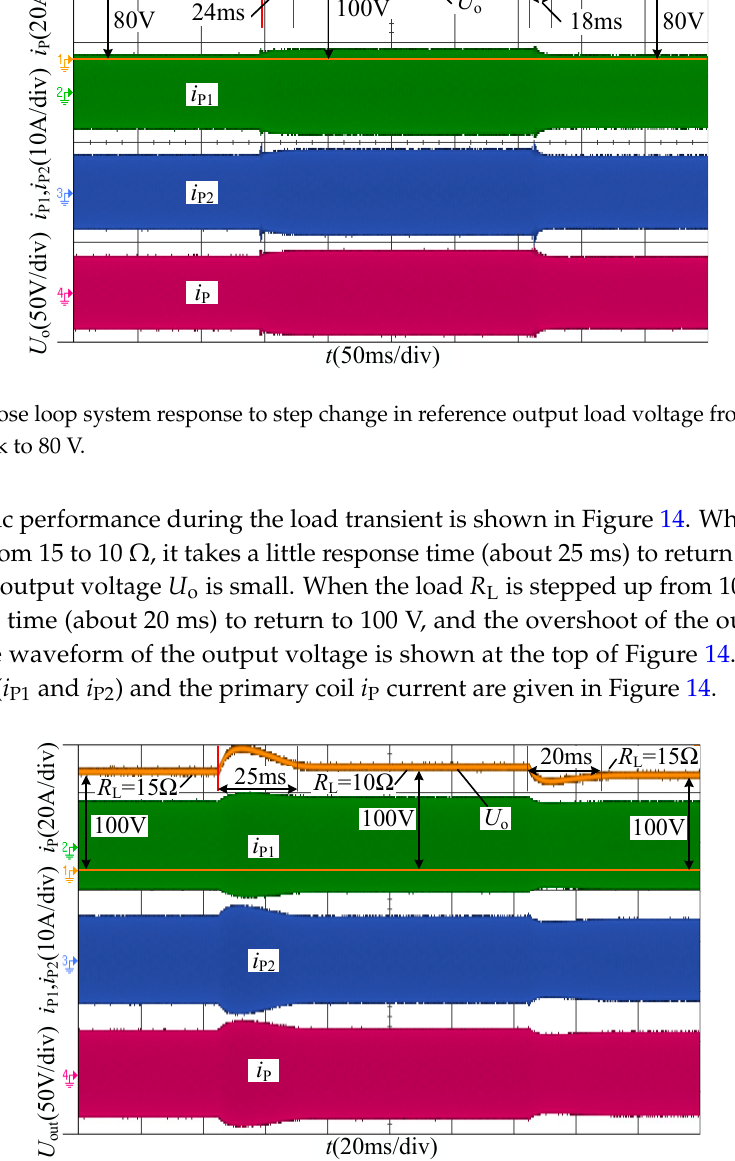
Figure 13. Meanwhile, the branch currents ( i P1 and i P2 ) and the primary coil i P current are given in Figure 13.